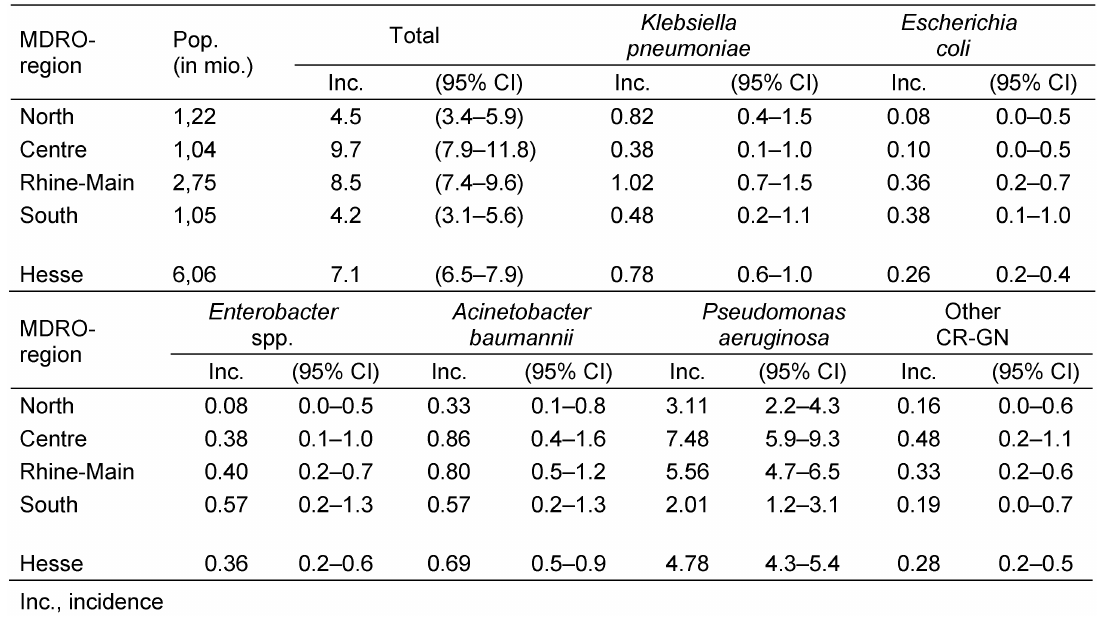
Table 5: Antimicrobial susceptibility of reported K. pneumoniae, A. baumannii and P. aeruginosa isolates, Hesse,